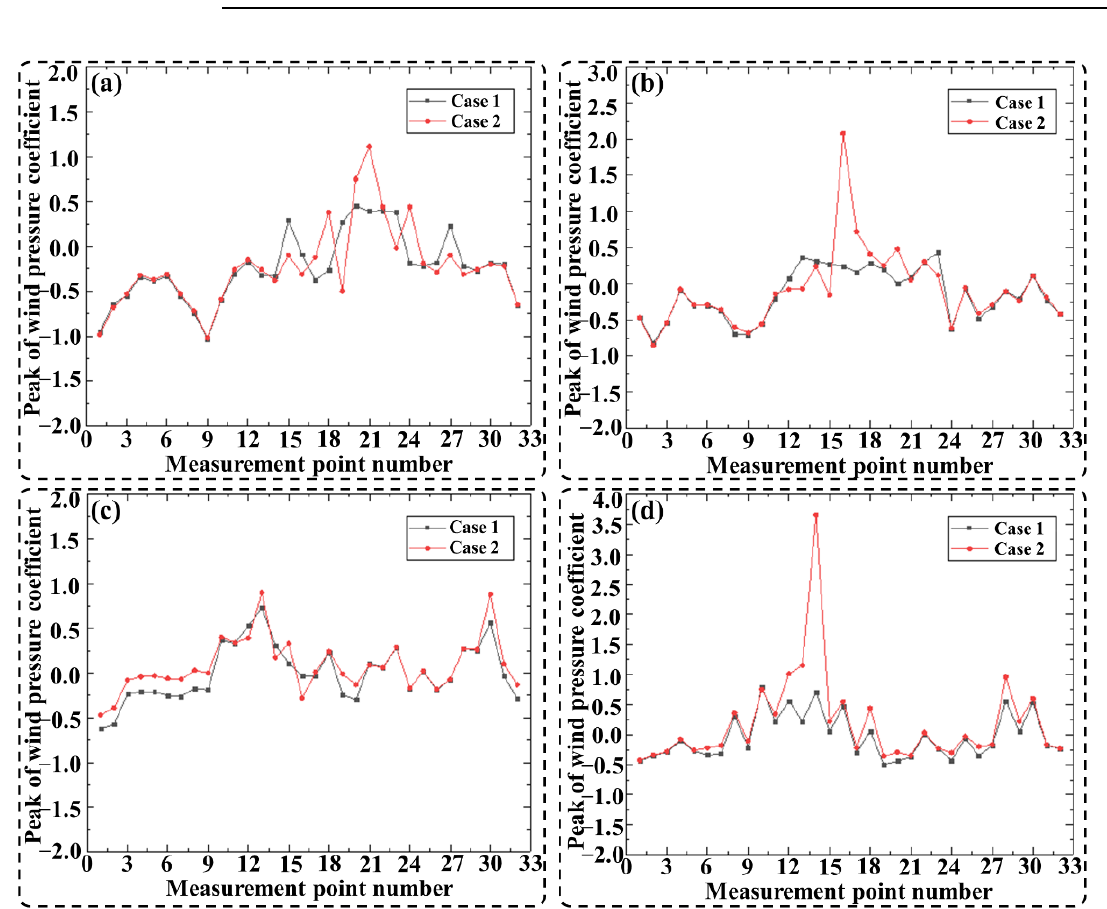
Figure 19. Maximum value of wind pressure coefficient of cross-section under each wind angle: ( a ) 0°; ( b ) 30°; ( c ) 60°; ( d ) 90°.